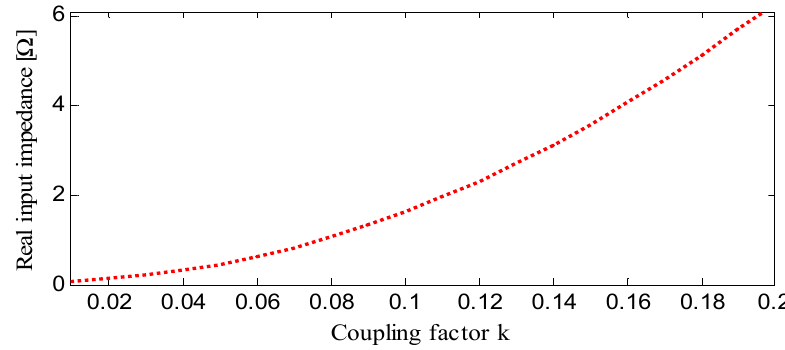
Figure 9. Input impedance vs. coupling factor k .